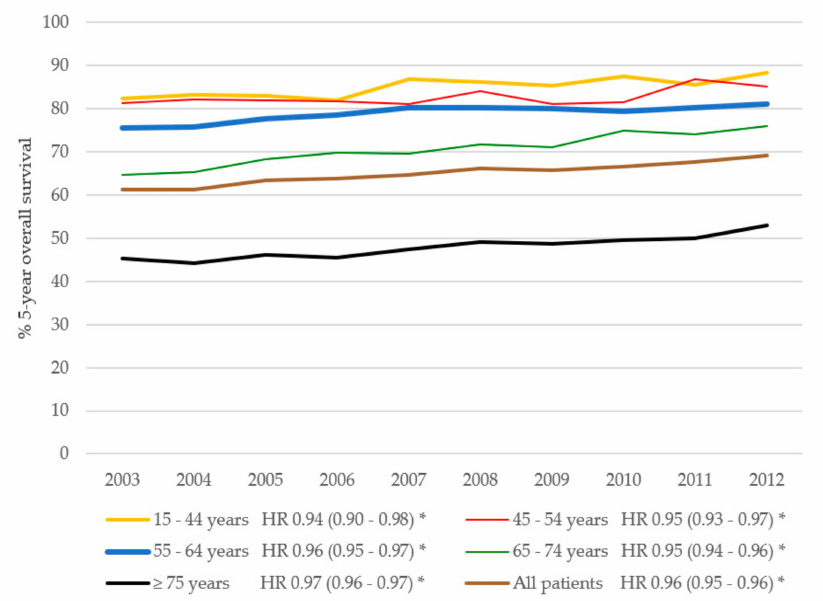
Figure 6. Five-year overall survival in CRC patients over time per age group. HR indicates the hazard ratio per year, adjusted for grade, stage, gender, and treatment. * Significant ( p < 0.05).